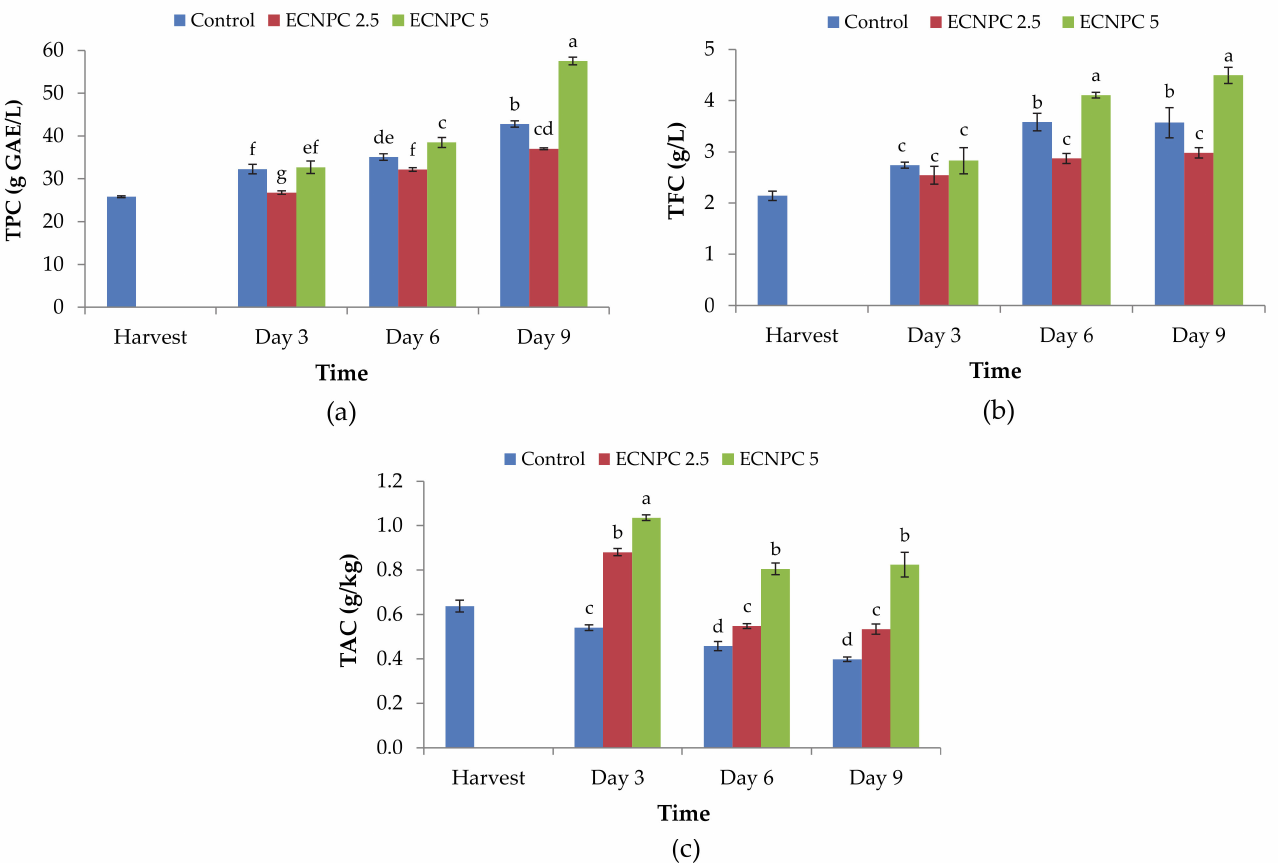
Figure 3. Effect of chitosan nano-emulsion coatings treatment (at 0 g L − 1 , 2.5 g L − 1 , and 5 g L − 1 ) on ( a ) total phenolics content, ( b ) total flavonoid content, and ( c ) total anthocyanin content of raspberries stored for 9 d (at 4 ± 1 ◦ C with 90–95% RH). Control refers to untreated raspberries. The data shown are the mean ± standard error of four replicates. Different letters indicate statistical significance ( p <